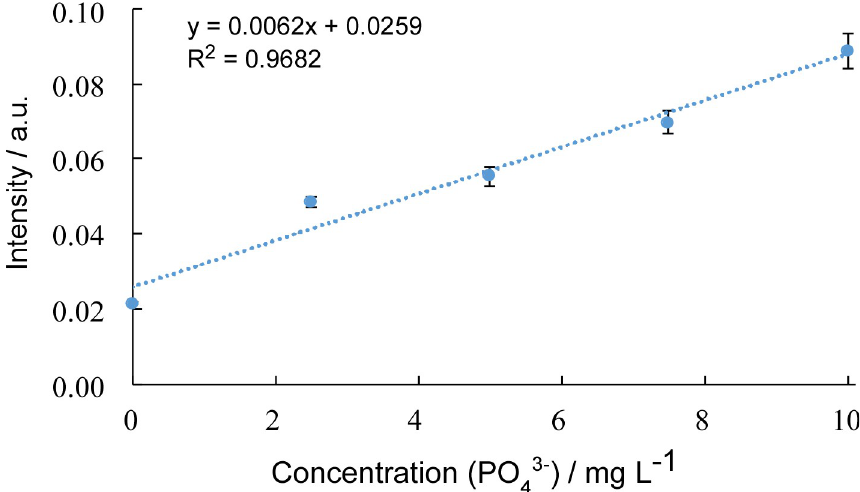
Fig 6. Typical calibration curve obtained with images captured from a smartphone camera. The obtained colour development in the sample reaction zones were standardised against both the internal standard (blue square) and the negative controls to account for interferences from varying light conditions and background colour from the water sample (n = 6).